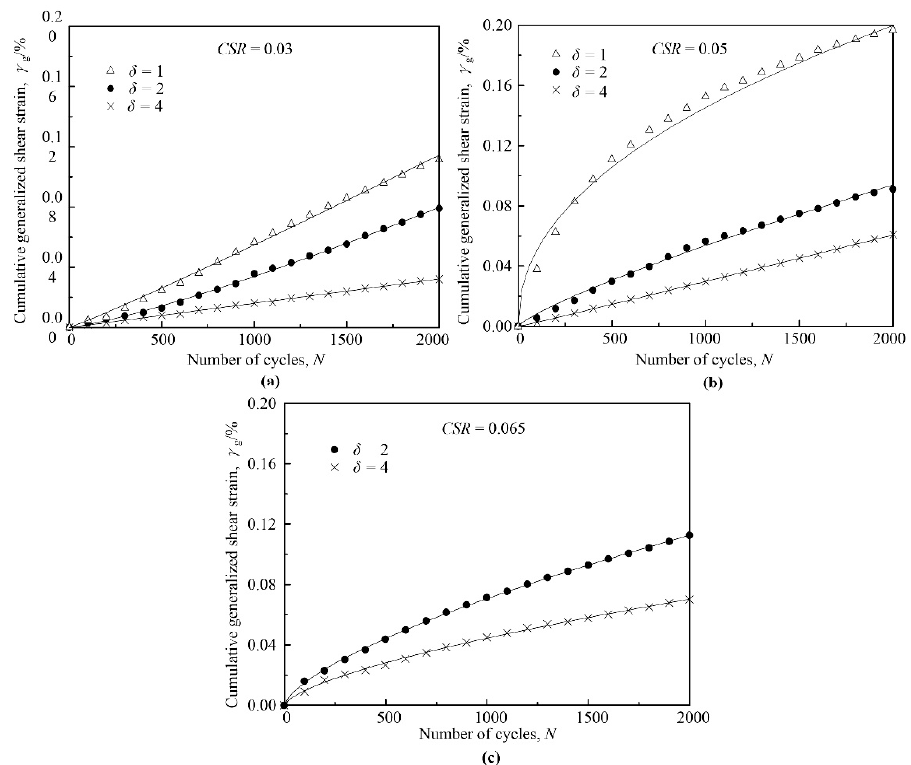
Figure 9. Relationship between cumulative generalized shear strain and number of cycles under the same CSR . ( a ) The relationship between cumulative generalized shear strain and number of cycles when CSR = 0.03; ( b ) The relationship between cumulative generalized shear strain and number of cycles when CSR = 0.05; ( c ) The relationship between cumulative generalized shear strain and number of cycles when CSR = 0.065.